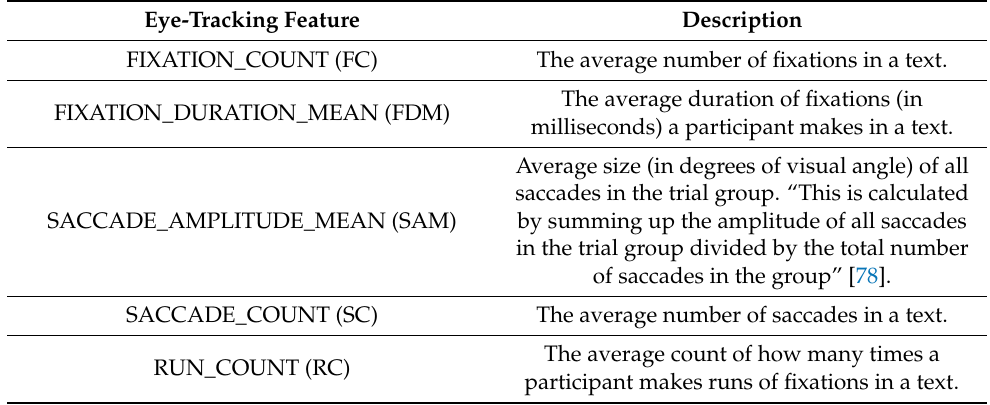
Table 7. Used eye-tracking features for each text.